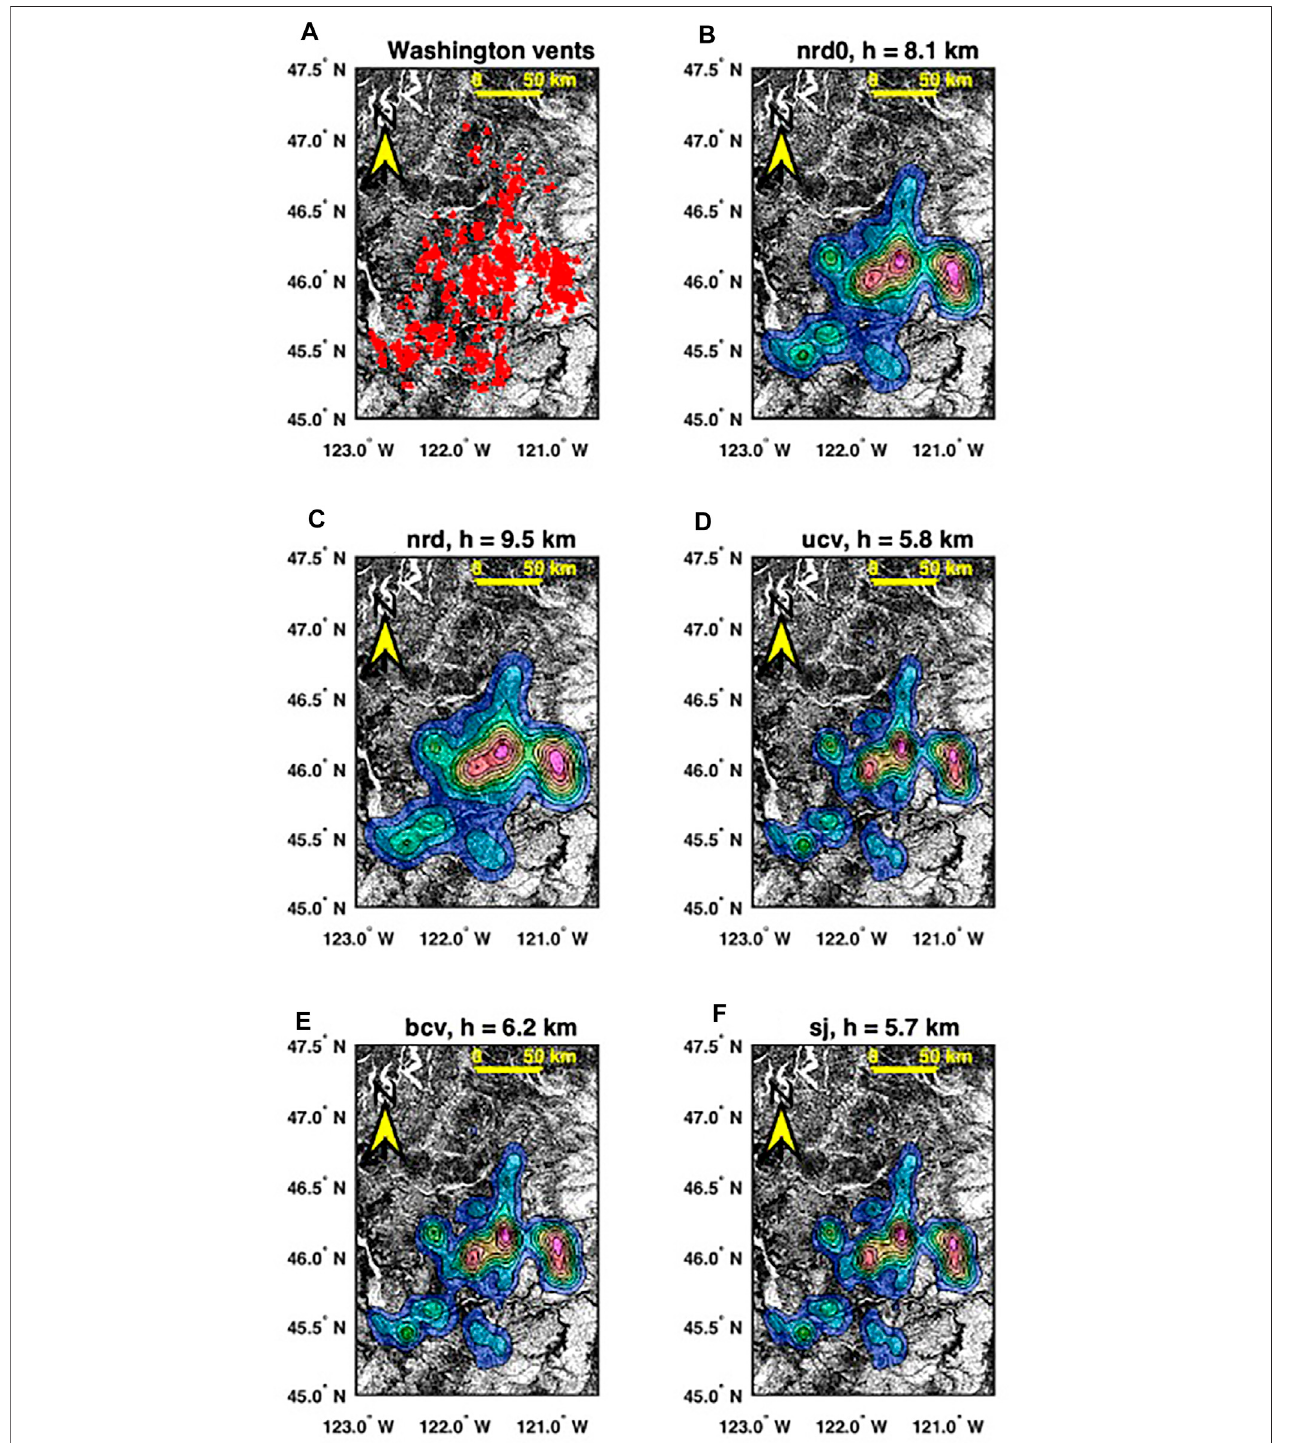
FIGURE5 | Estimated PDFs using the selector and corresponding bandwidth asindicated on top ofeach panel. The fi rst panel (A) shows the location ofthe vents used for the calculations (red triangles). Washington Cascades example.